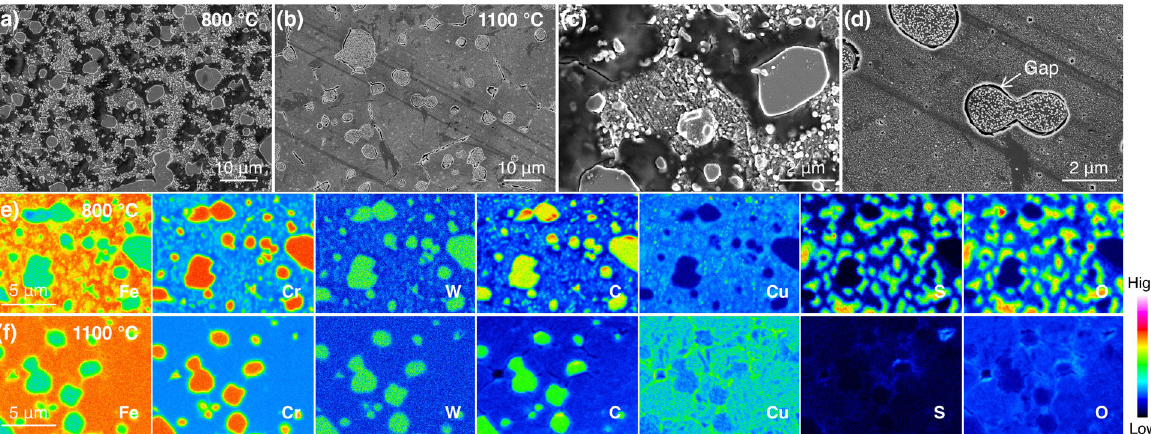
Fig. 5 Sur fi cial elemental distributions of the corroded surfaces. a – d SEM images and e , f EPMA elemental maps of the surface regions of the 16Cr steel samples quenched from a , c , e 800 °C and b , d , f 1100 °C after immersion in the 0.5 M H 2 SO 4 solution for 1 h. High-magni fi cation images of panels a and b are shown in panels c and d , respectively. In the EPMA maps, the intensity range in e and f was the same for each element.